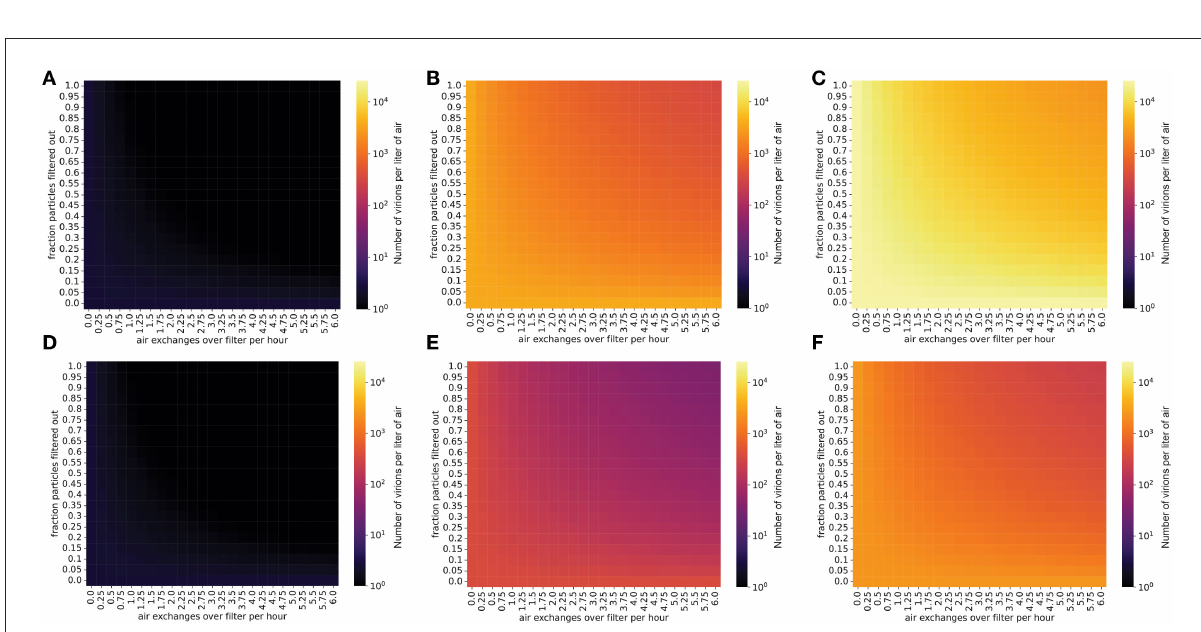
FIGURE2 Steady-state concentrations of virions are strongly impacted by air exchange rate across the filter and by the fraction of particles removed when air is passed over the filter. Virion concentrations at steady state, in a room 10 ′ x 20 ′ x 20 ′ . (A–C) Individual infected with a low viral load, (A) intermediate viral load, (B) or high viral load, (C) strain, no mask. (D–F) Individual infected with a low viral load, (D) intermediate viral load, (E) or high viral load, (F) strain, wearing a 90% effective mask. Typical air purification systems can achieve a filtration rate of approximately 5–6 exchanges/h (Supplementary material